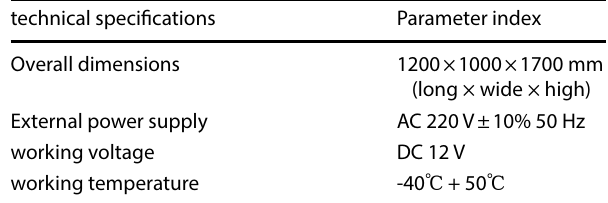
Table 1 Parameters of Test Bench technical specifications